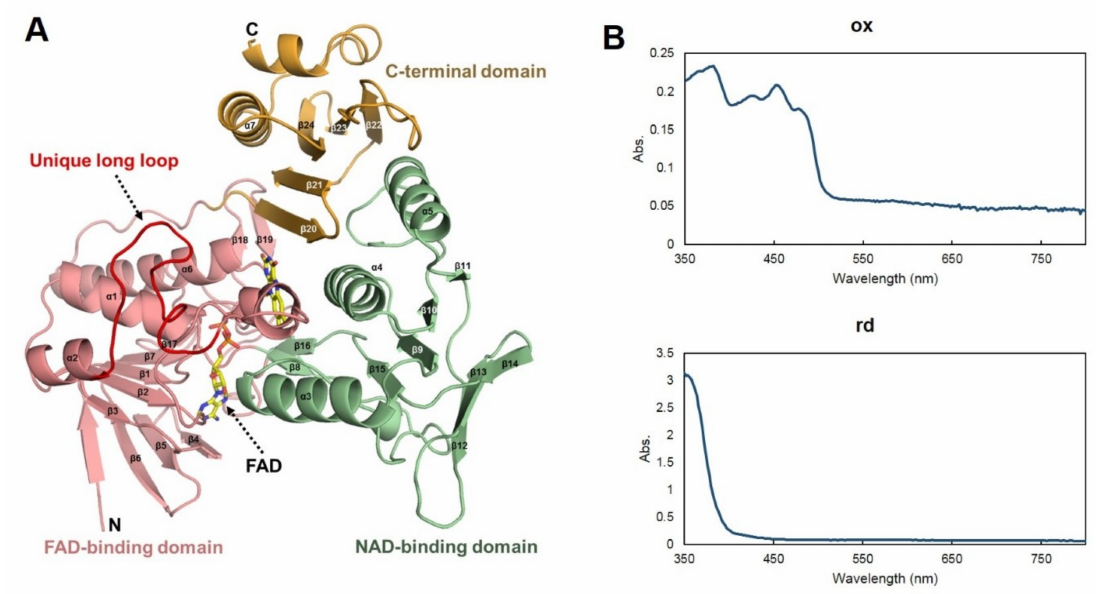
Figure 2. Overall structure ( A ) and UV-visible spectrum ( B ) of DaMDHAR. The FAD, NAD-binding domains, and C-terminal domains are colored light pink, light green, and yellow, respectively. Specifically, the bound FAD molecule is presented as a stick model. The UV-visible spectrum of OsMDHAR was monitored in the absence (oxidized, ox) and the presence of NADH (reduced, rd) in the solution